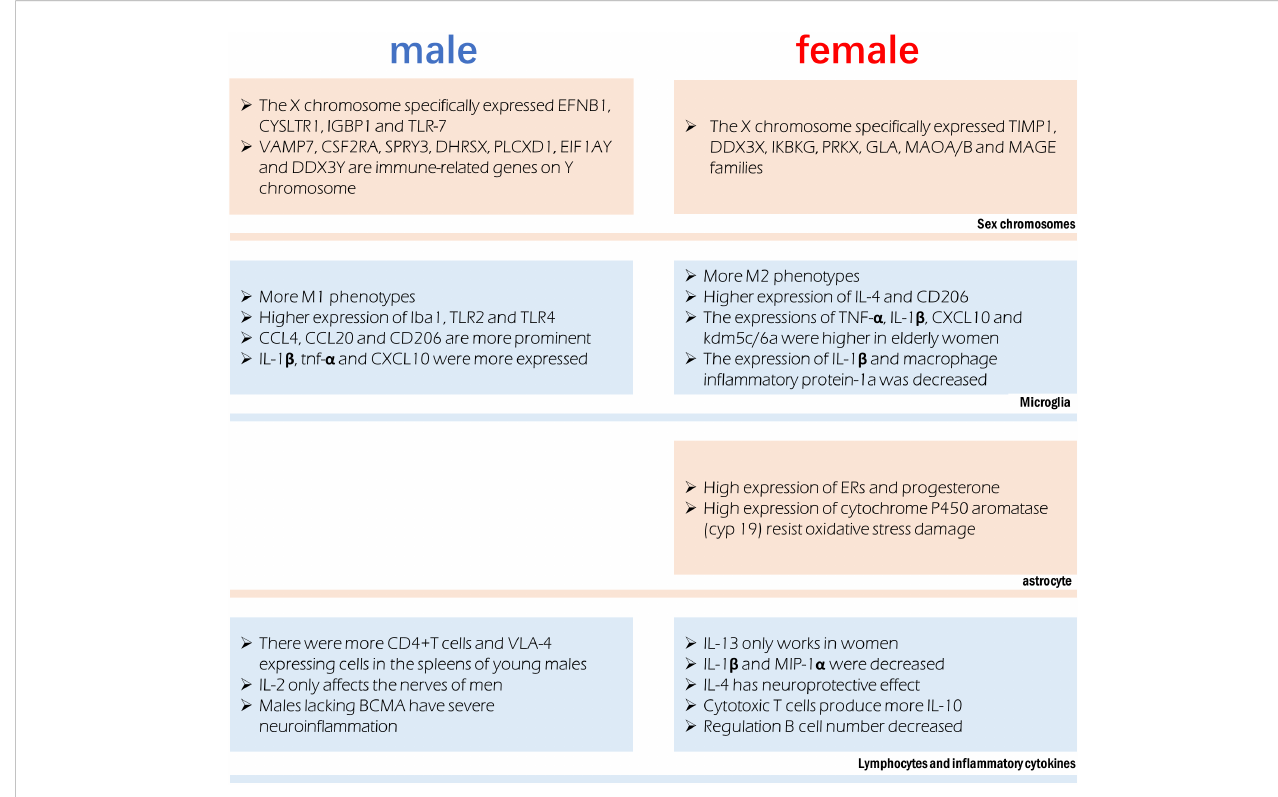
FIGURE 2 Sex difference involved in immune regulation after stroke. Different chromosomes host the expression of speci fi c genes that can in fl uence immune function. Microglia were more prone to the M1 phenotype in males and M2 phenotype in females, however their production of cytokines is also affected by age. Astrocytes in females have a more anti-in fl ammatory phenotype. Signi fi cant sex differences exist in the in lymphocytes and the cytokines they